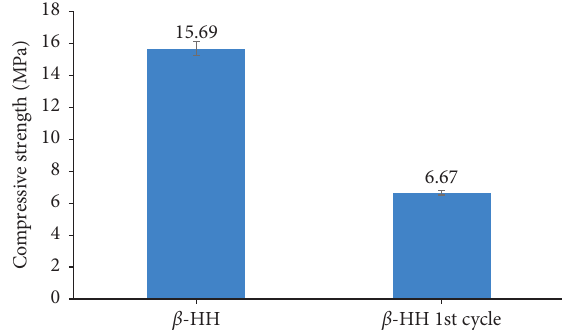
Figure 6: The compressive strength of the β -HH and β -HH after the first